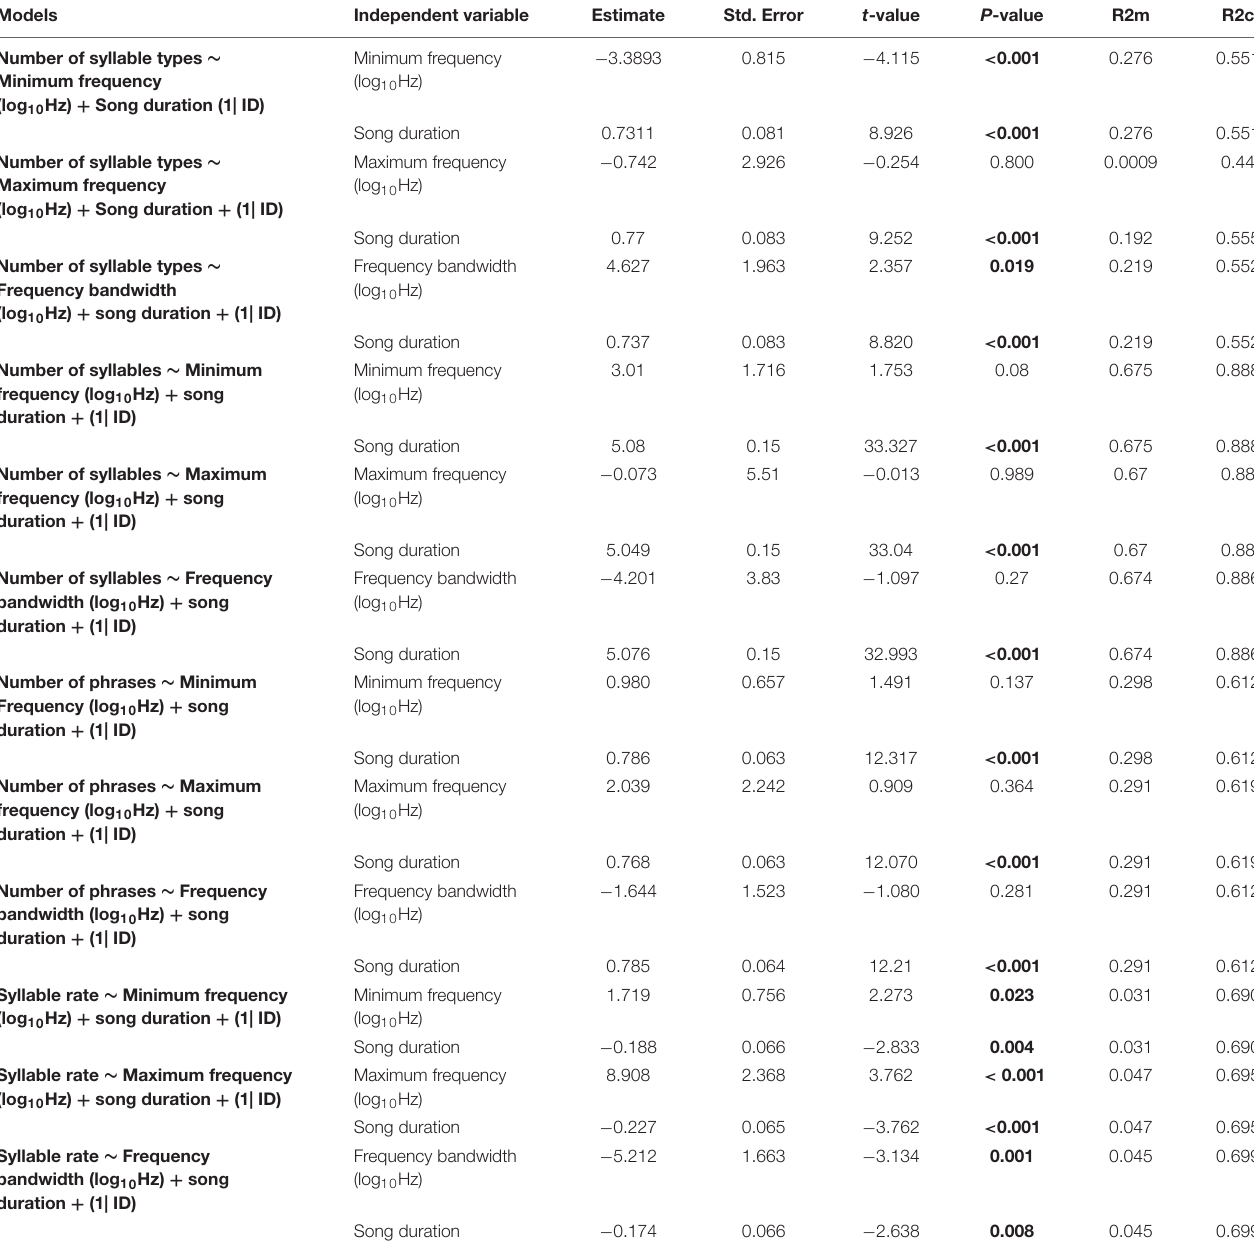
TABLE 3 | Fitted linear mixed models of the elaboration song measurements on the spectral song variables and song duration. Models Independent